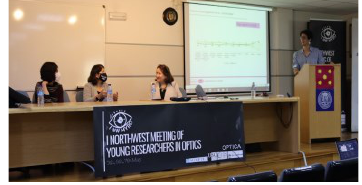
Fig. 1. Women in Optics roundtable, featuring female researchers at different stages of their careers.